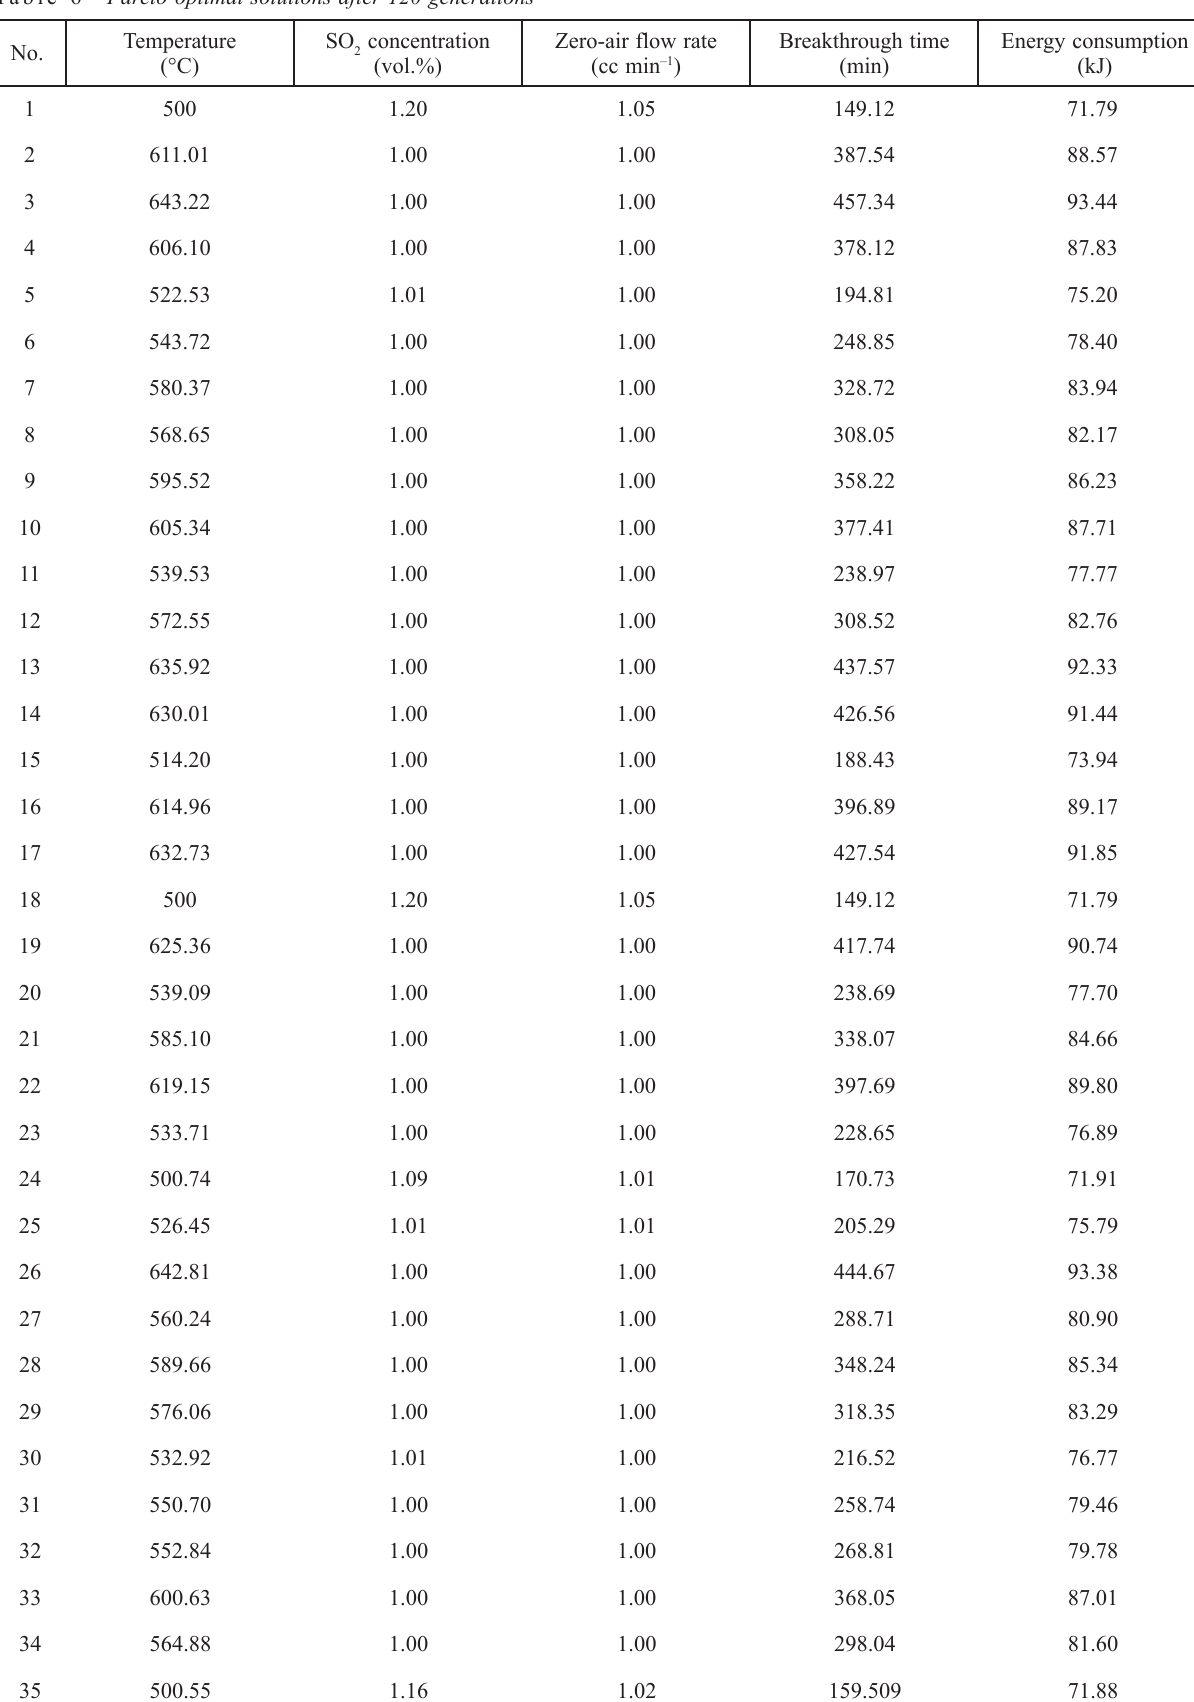
Table 6 – Pareto-optimal solutions after 120